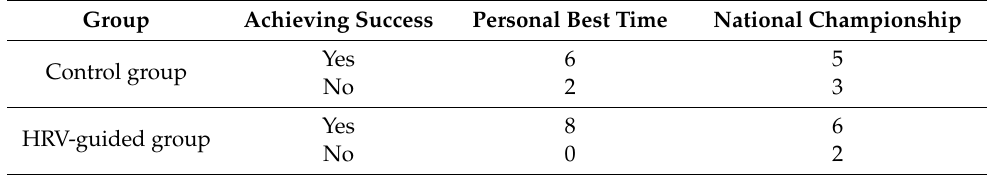
Table 3. Number of athletes in the HRV-guided and control training groups setting personal records or achieving success in the National